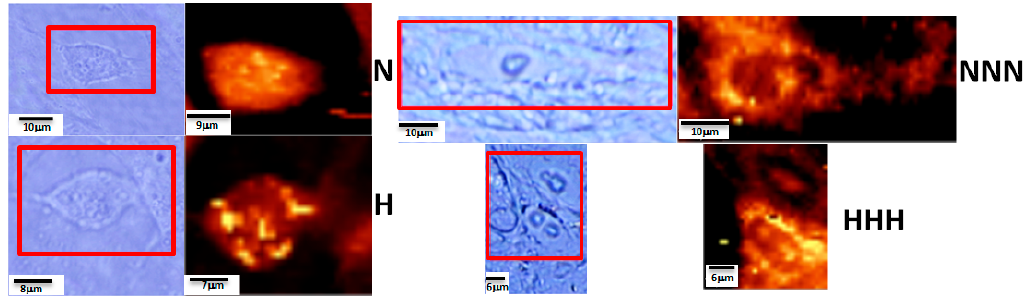
Figure 3. Microscopy images and the respective Raman images of pAds (N, H) and mature Ads (NNN, HHH) for intracellular structures: lipid structures (triacylglycerides (TAGs)), fatty acids (FAs) and cholesterol esters (CEs), (2840–2900 cm − 1 ).